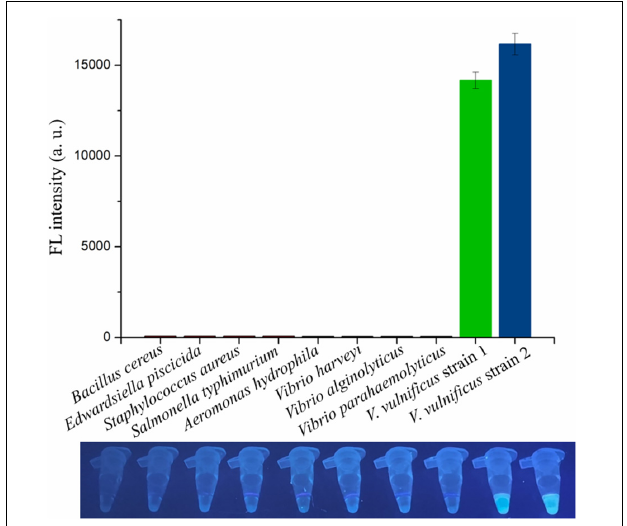
FIGURE 5 | Evaluating the specificity of RAA-CRISPR/Cas12a assay in V. vulnificus detection. Ten bacterial strains were used to evaluate the specificity of RAA-CRISPR/Cas12a assay, and the fluorescence sigils were analyzed using a multifunctional microplate reader (upper) or a UV torch (below). V. vulnificus strain 1 was isolated from eel, and strain 2 was isolated from